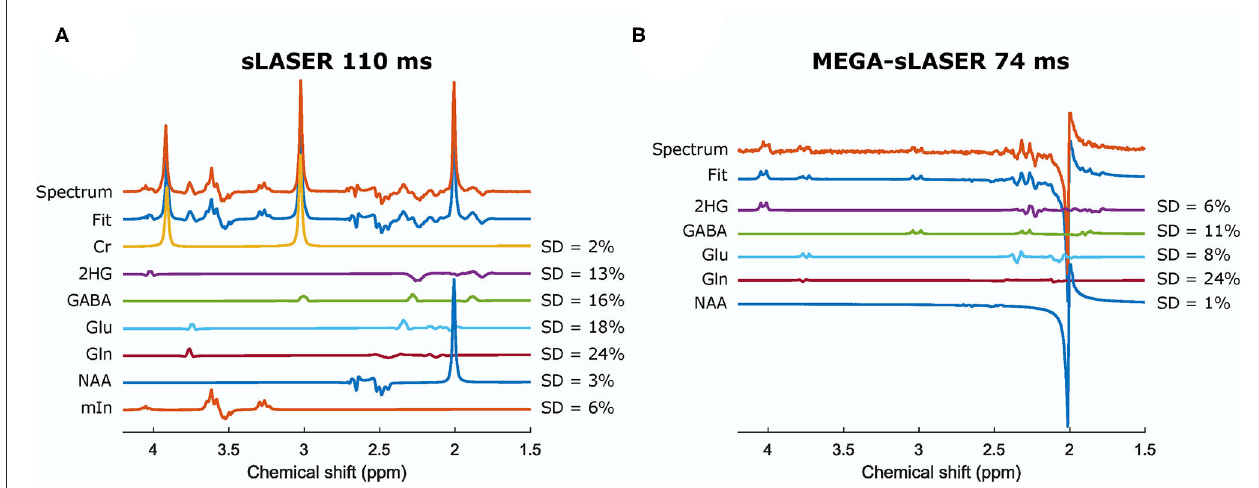
FIGURE 4 | Spectra and the fits from a phantom containing 2HG, Cr, NAA, Glu, Gln, GABA, and mIn acquired from sLASER TE = 110ms (A) and MEGA-sLASER TE = 74ms (B) . The relative concentrations (/NAA) can be found in Table 2 . Cr, creatine; NAA, N-acetylaspartate; Glu, glutamate; Gln, glutamine; GABA, γ -aminobutyric acid; mIn, myo-inositol.